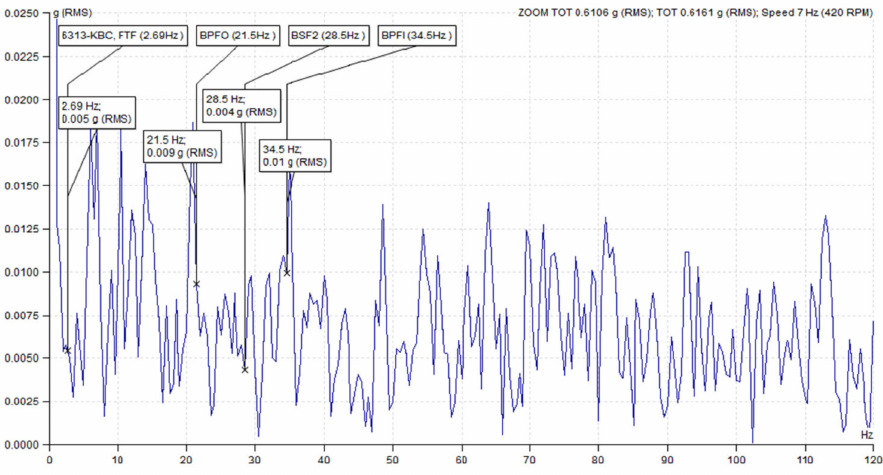
Figure 17. The fast Fourier transform (FFT) (500 Hz–16 kHz) demodulation 6313 KBC of the non-driving end of the tangential threshing drum rotating at 420 rpm with the sensor mounted on the housing.